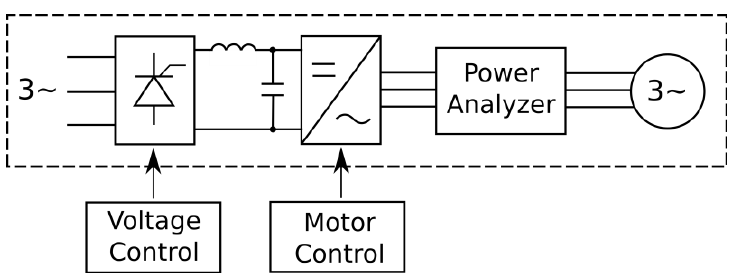
Figure 5. Block diagram of the inverter-supplied induction motor.